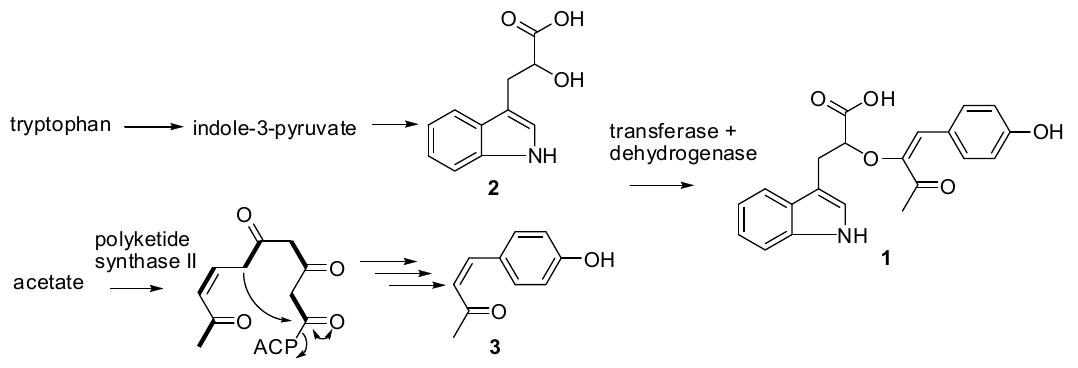
Figure 6. Proposed biosynthesis of Digyaindoleacid A ( 1 ).